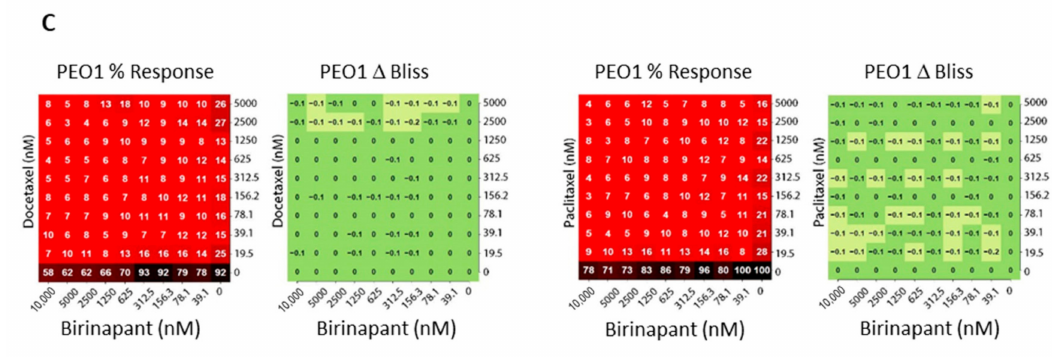
Figure 1. Birinapant is synergistic with specific classes of drugs. ( A ) Matrix screen was performed with PEO1 cell line. Excess HSA values are shown for each of the 1912 compounds in combination with birinapant. Clinically interesting combinations are listed at the right. ( B ) Drugs were categorized by mechanism of action and grouped based on matrix screen results. Shown are classes of drugs identified as having synergistic activity with birinapant. Classes fell into distinct categories such as taxanes, HDAC inhibitors, and PLK-1 inhibitors. ( C ) Matrix plots for docetaxel and paclitaxel showed a strong combination e ff ect even at low concentrations of both drugs. Red / black plot shows % viability based on Caspase-Glo assay, and green plot shows delta Bliss where negative numbers indicate synergy.